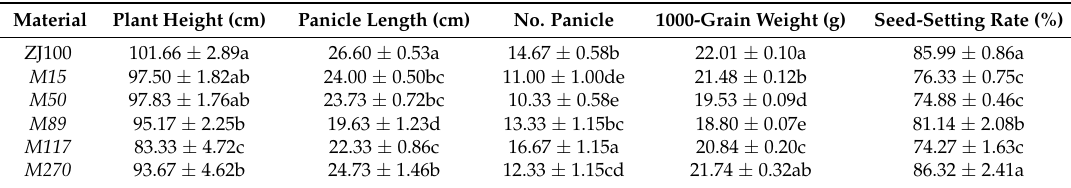
Figure 1. Phenotypes of psl mutants and wild type (WT). ( A ) WT at the tillering stage; ( B ) psl15 at the tillering stage; ( C ) psl50 at the tillering stage; ( D ) psl89 at the tillering stage; ( E ) psl117 at the tillering stage; ( F ) psl270 at the tillering stage; ( G ) WT at the grain-filling stage; ( H ) psl15 at the grain-filling stage; ( I ) psl50 at the grain-filling stage; ( J ) psl89 at the grain-filling stage; ( K ) psl117 at the grain-filling stage; ( L ) psl270 at the grain-filling stage. Insets show magnified views of bottom second leaves. Scale bar = 20 cm. Table 1. Agronomic traits of the mutants and wild type.